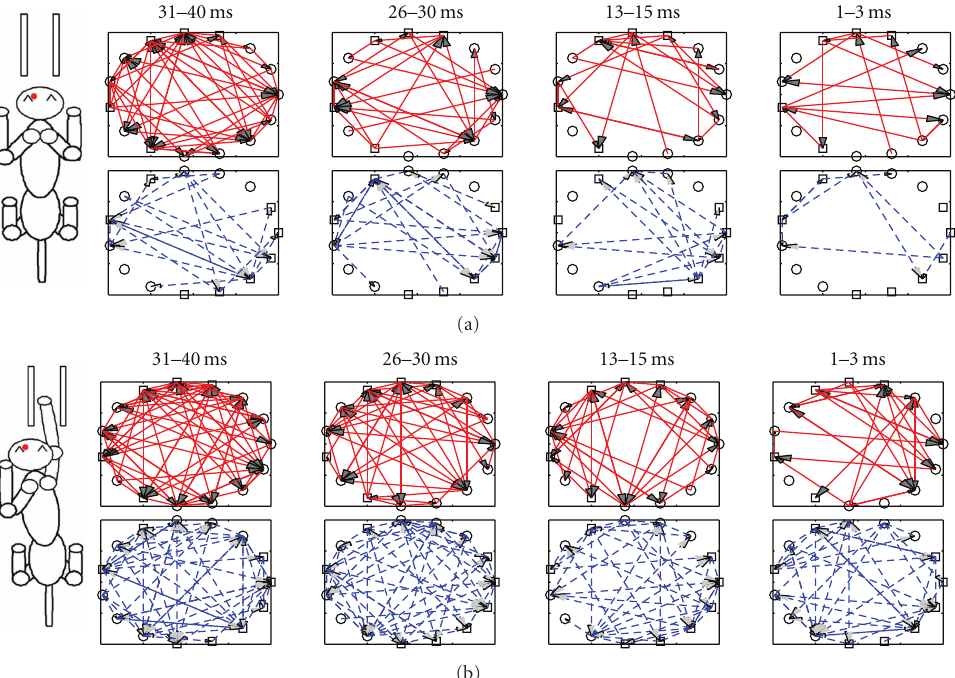
Figure 3: Illustrations of excitatory (red, top row) and inhibitory (blue, bottom row) functional connectivity among 15 ensemble MI neurons (Dataset-3) recorded from the left cerebral hemisphere of one of the animals during the background (a) and reaching (b) stages of successful task trials. Circles and squares represent the RS and FS cells, respectively. Uni- or bidirectional arrow indicates directional statistical dependence between cells, with solid/dashed lines representing excitatory/inhibitory connections. The numbers above each panel of connectivity maps indicate the di ff erent spiking history windows that were selected to detect the associations. Note the significant increase in both inhibitory and excitatory spiking associations that occurred during reaching when compared with background, and di ff erent pairs of neurons are involved in functional interactions during di ff erent behavioural